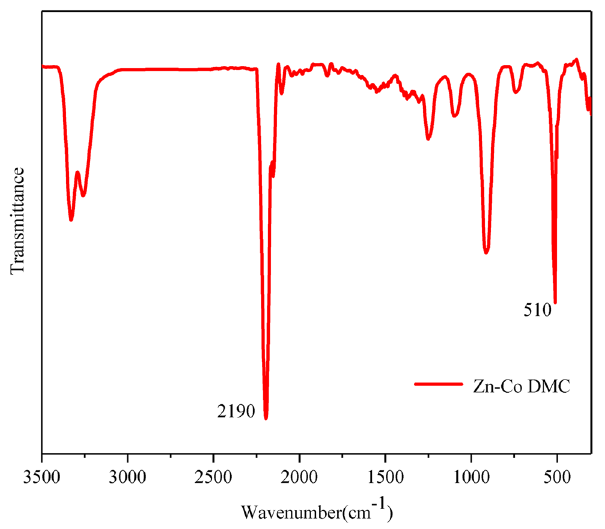
Figure A1: FT - IR spectrum of catalyst Zn – Co DMC complex.